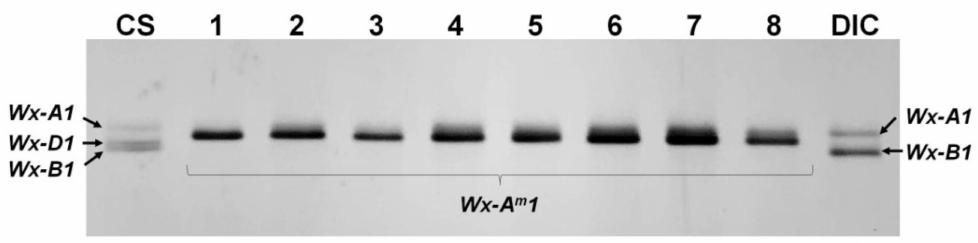
Figure 4. SDS-PAGE of representative variation for waxy proteins found in the wild einkorn collection. Lanes are as follows: CS , common wheat cv. Chinese Spring; 1 , PI 554559; 2 , PI 427622; 3 , PI 554504; 4 , PI 554548; 5 , PI 427453; 6 , PI 470720; 7 , PI 470713; 8 , PI 427575; and DIC, emmer wheat landrace PI